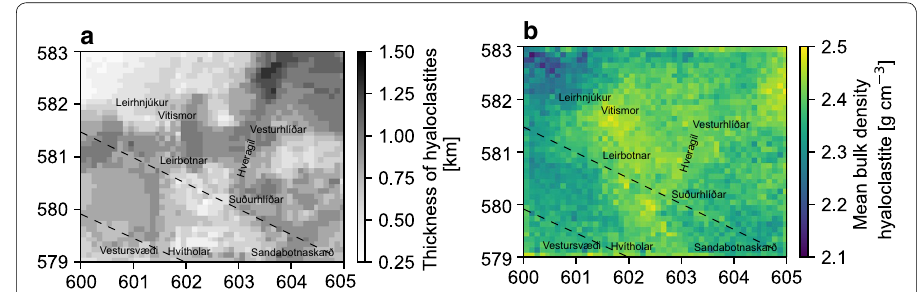
Fig. 15 Spatial variations in a hyaloclastite thickness and b mean bulk density of hyaloclastite for Case 5b. Boundary of low gravity structure shown with dashed